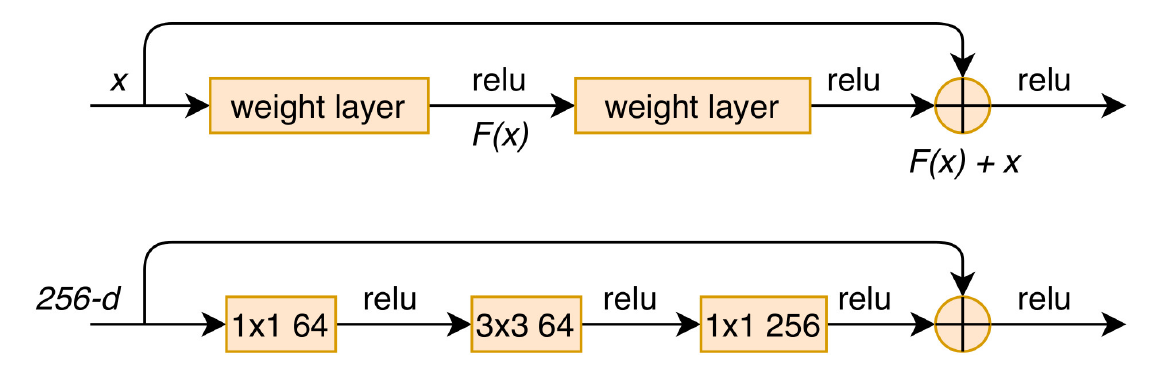
Figure 2. Residual block (top) and “bottleneck” block (bottom) of ResNet [32].